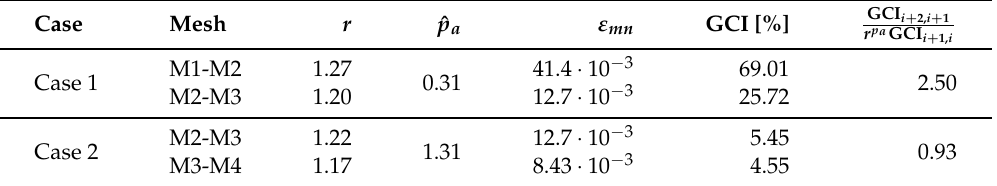
Table 4. Overview of GCI analysis for the Minifors 2 stirred bioreactor with a stirrer speed of